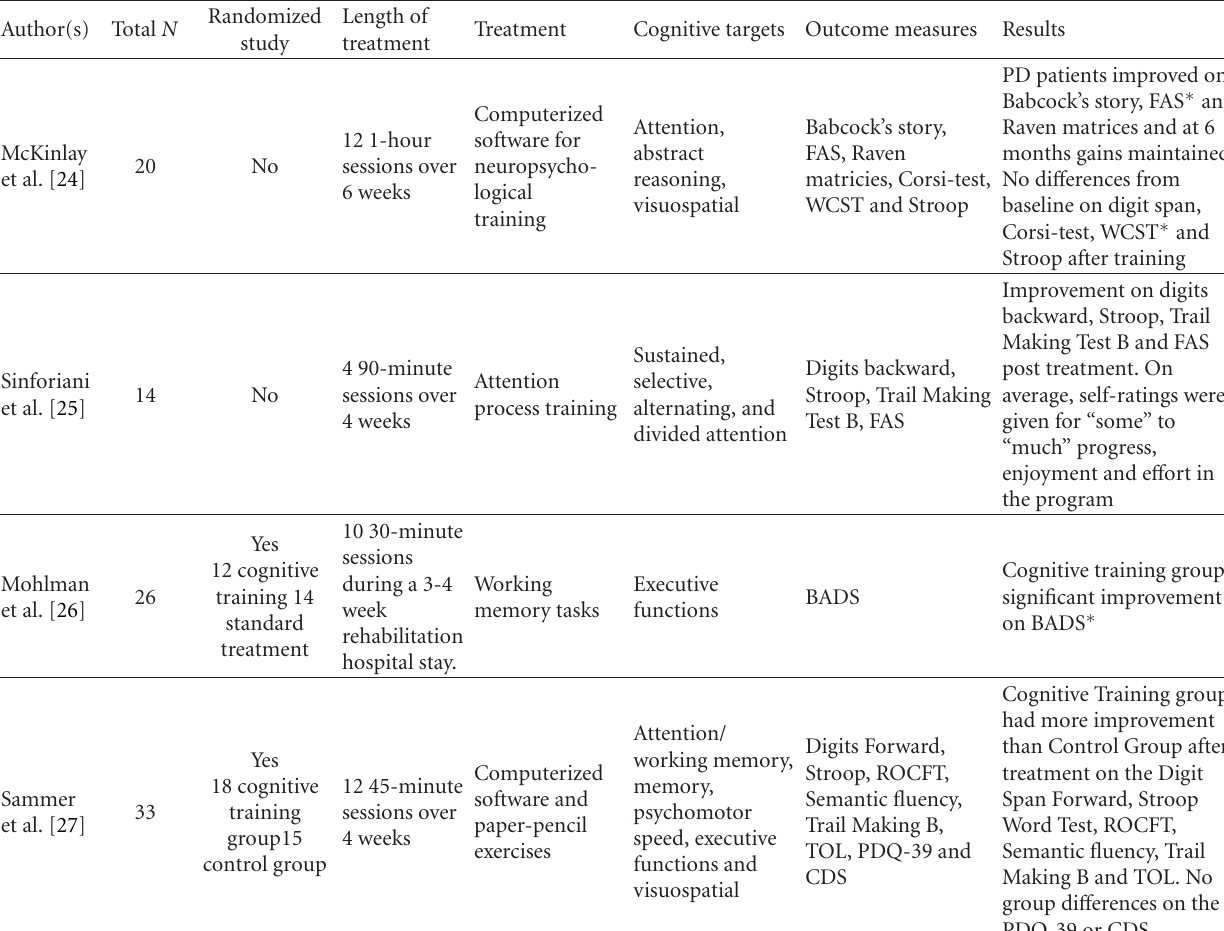
Table 1: Cognitive training programs for patients with Parkinson’s